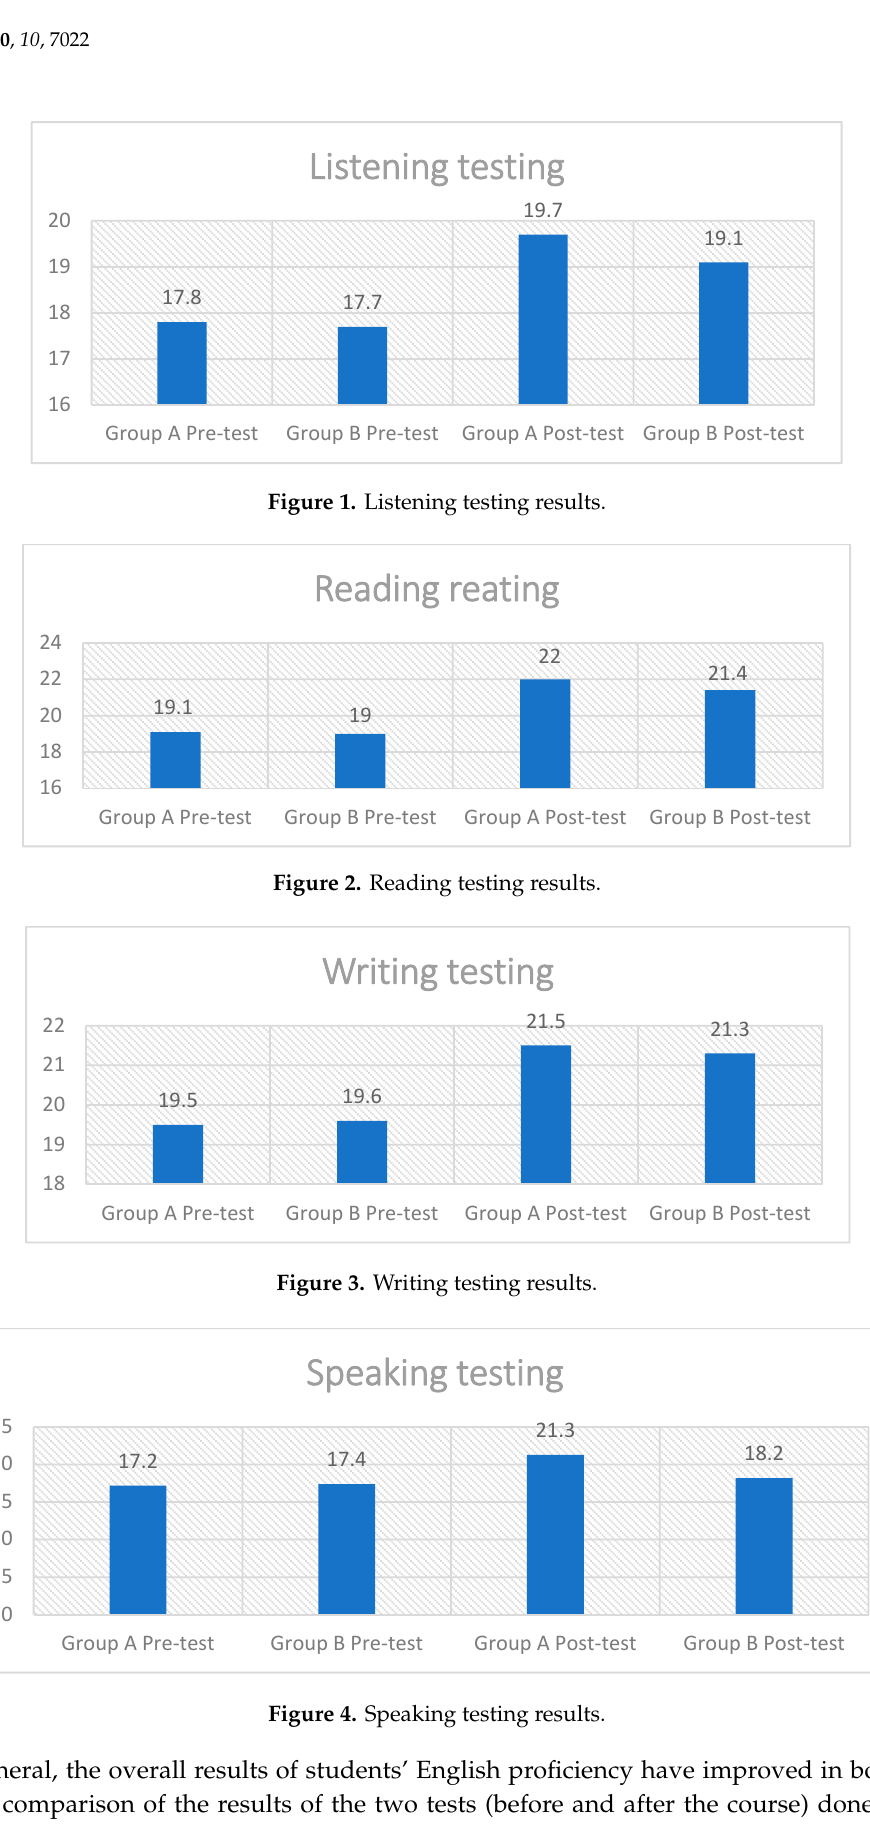
Table 1. Descriptive statistics (results of pre-test and post-test on English). Category